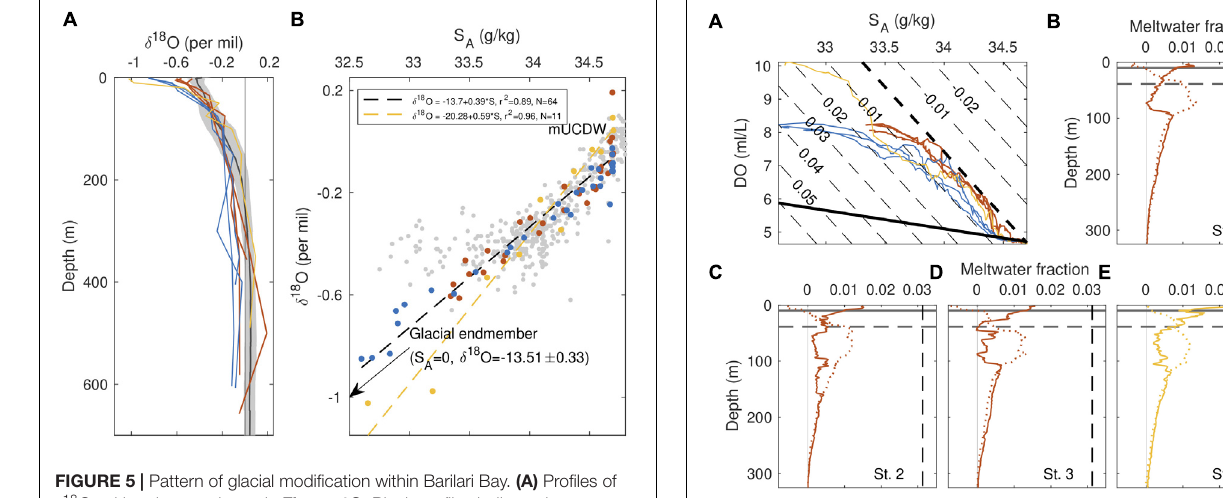
FIGURE 5 | Pattern of glacial modification within Barilari Bay. (A) Profiles of δ 18 O, with colors as shown in Figure 1C . Black profiles indicate the mean δ 18 O profiles for continental shelf stations sampled between the 300 and 600 lines of Palmer-LTER (approximately 64–66 ◦ S), with properties averaged along isopycnals. Gray patch denotes one standard deviation about the mean. Gray vertical line denotes δ 18 O = 0 . (B) δ 18 O-salinity plot for profiles shown in (A) . Gray points are discrete measurements collected on the WAP shelf between (cid:104) the 300 and 600 lines of Palmer-LTER. Black and yellow dashed lines correspond to linear regressions on the full dataset from this study and station 4 (yellow points), respectively, with regression statistics shown in the legend.